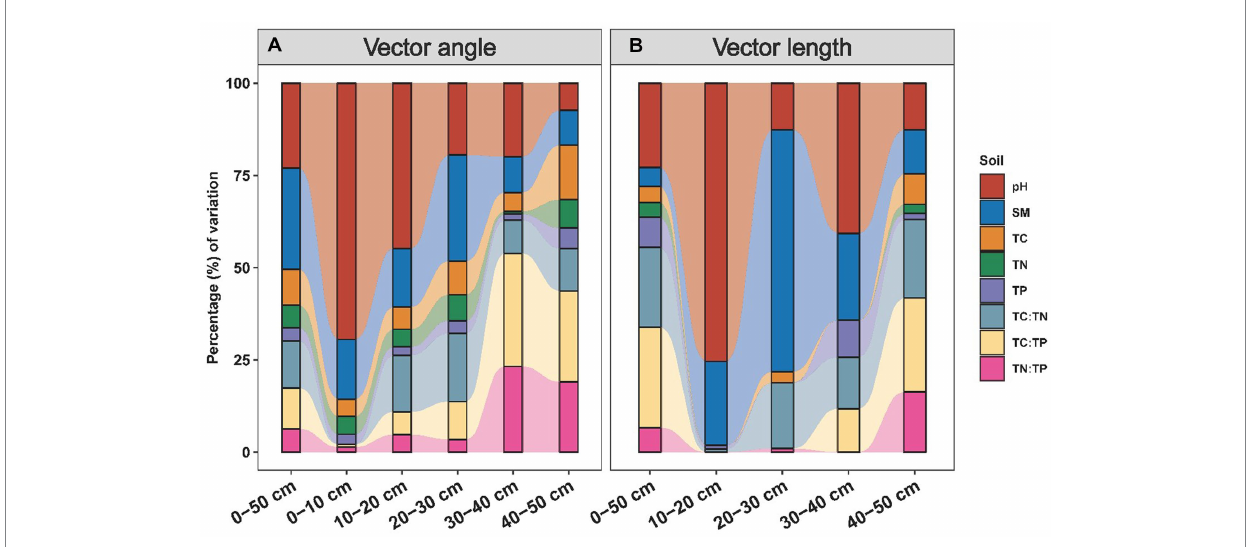
FIGURE 5 Influences of soil variables on vector angles (A) and lengths (B) . Percentage of variation in vector angles and lengths explained by soil variables. SM, soil moisture; pH, soil acidity and alkalinity; TC, total carbon; TN, total nitrogen; TP, total